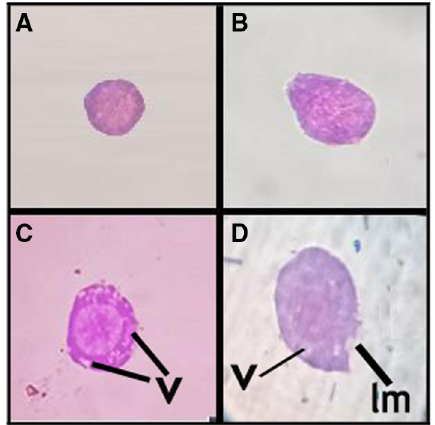
Fig. 6 Morphological changes in prohaemocytes ( x Control (normal larvae), B F1 larvae (from irradiated male parent pupae with 100 Gy), C larvae feed on treated leaves with LC 50 , D F1 larvae feed on treated leaves with LC 50 . v: vacuole, lm: lysed membrane enlargement and vacuolation of the cytoplasm. In addi- tion the prohaemocyte membrane was lysed in F1 larvae. Plasmatocytes percentage was significantly declined in all examined larvae (F1, LC 50 and F1 the control. Parent irradiation with 100 Gy caused the cell to be enlarged or took slightly oval shape and the nucleus lost its central position and moved to the cell wall (Fig. 7B). M. anisopliae affect plasmatocytes in the same way of gamma radiation and inducing vacuolation of cytoplasm. The combined effect of M. anisopliae and radiation would be more destructive to cells than using